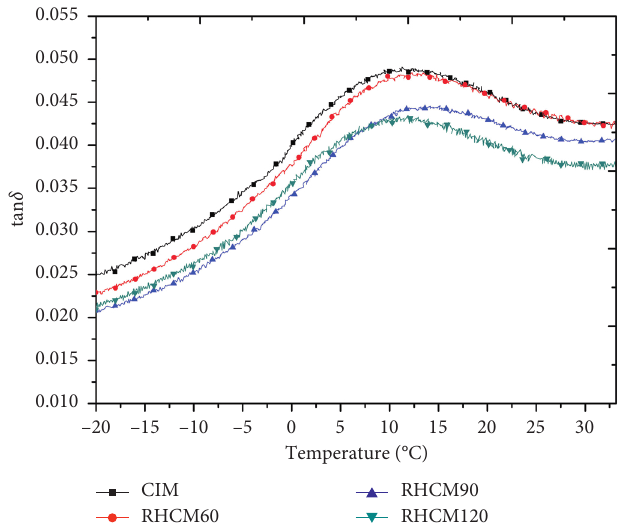
Figure 9: Mechanical loss (tan δ ) curve of RHCM and CIM samples.